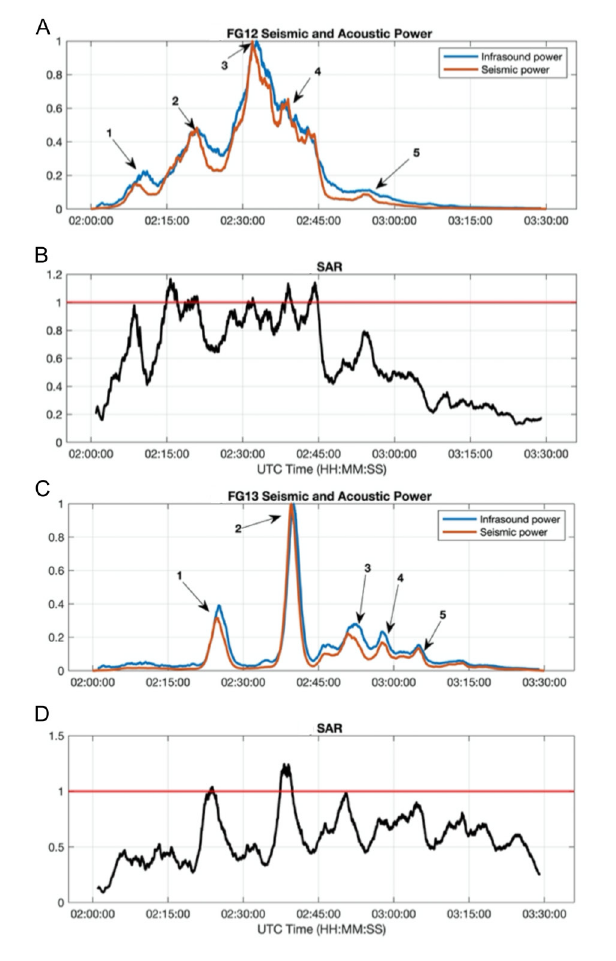
Figure 8: [A–D] Power differences ([A] and [C]) and Seismic-Acoustic Ratio, SAR ([B] and [D]) for their re- spective stations in relation to the energetics of the la- har event. The red line in B and D indicates a ratio equal to 1. The five identified pulses from Figure 5E–F have been numbered here for each station ([A] and [C]). Note the similarity between the seismic and infrasound, and the pronounced energy for both seismic and infrasound at FG13 ([C] and [D]). In order to smooth data and provide a better understanding of a broader energy relationship of the seismic and infrasound energy ratio, a relatively large median filter (120 s) was applied to the power cal- culations to suppress thunder